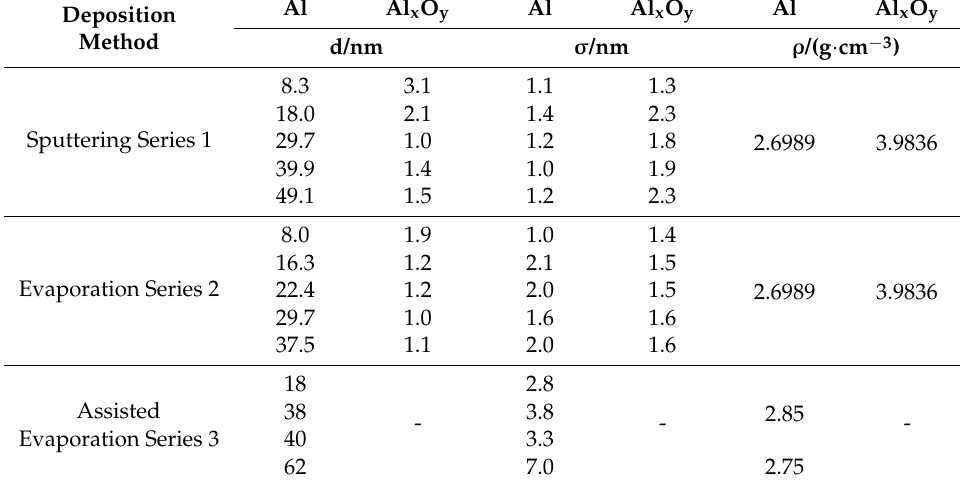
Table 4. Results of XRR